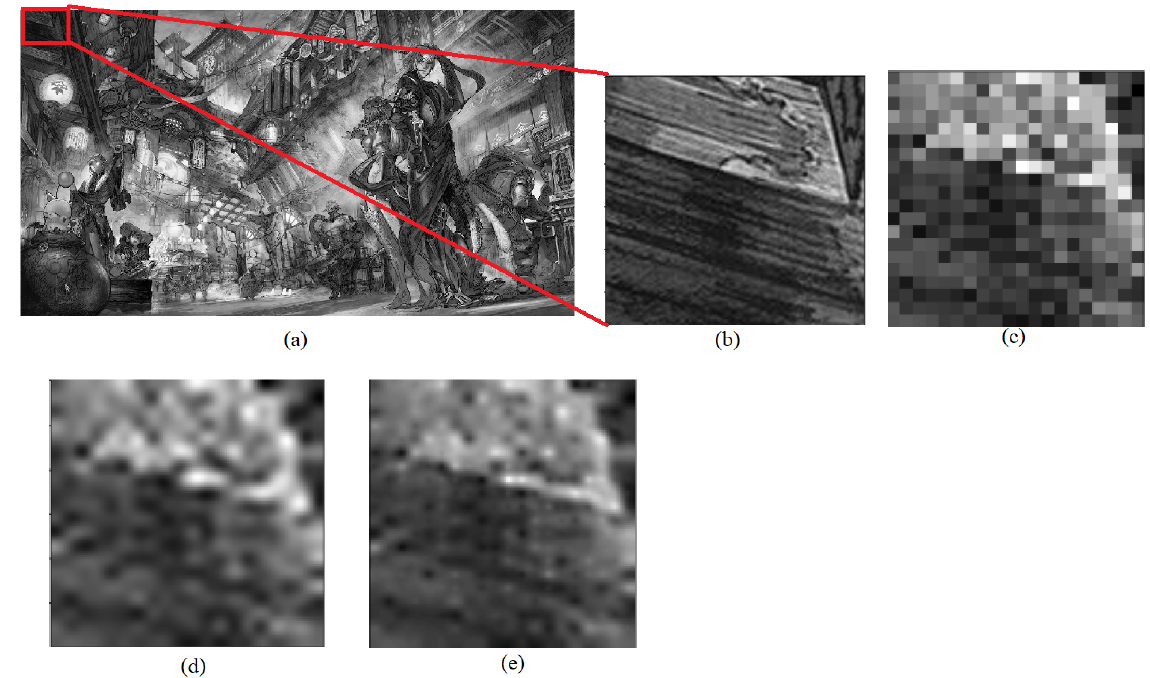
Figure 6. Comparison of deep machine learning based RTISR with the residual neural network to conventional bicubic upscaling: ( a ) Original 1080p image; ( b ) 120 × 120 high-resolution segment; ( c ) 20 × 20 downsampled segment as a system input; ( d ) Bicubic upsampled image [SSIM: 0.00816, MSE: 1514.09]; ( e ) Deep machine learning based RTISR [SSIM: 0.5292, MSE: